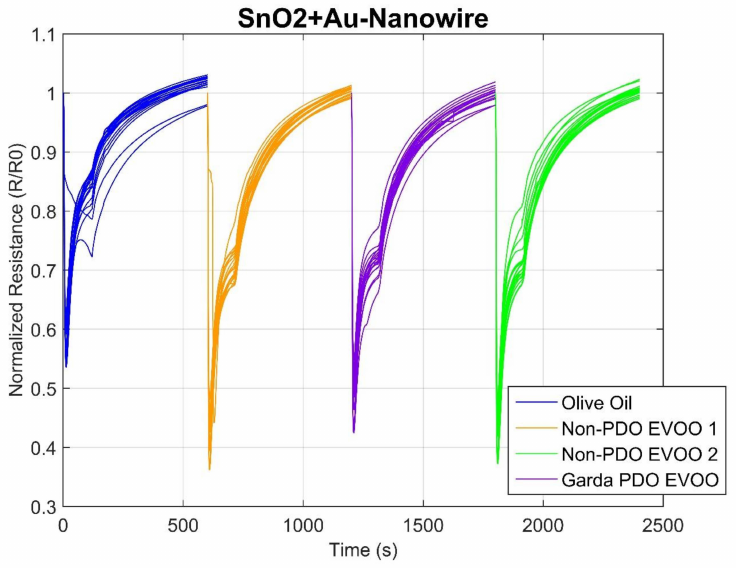
Figure 1. Typical resistance variation of a n-type sensor once exposed to oil volatile compounds. On the x-axis is time (s), on the y-axis is the normalized